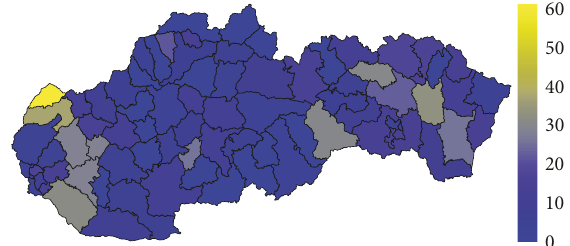
Figure 5: The standardised mortality rate of the female sex in the individual districts of the Slovak Republic in 2015.